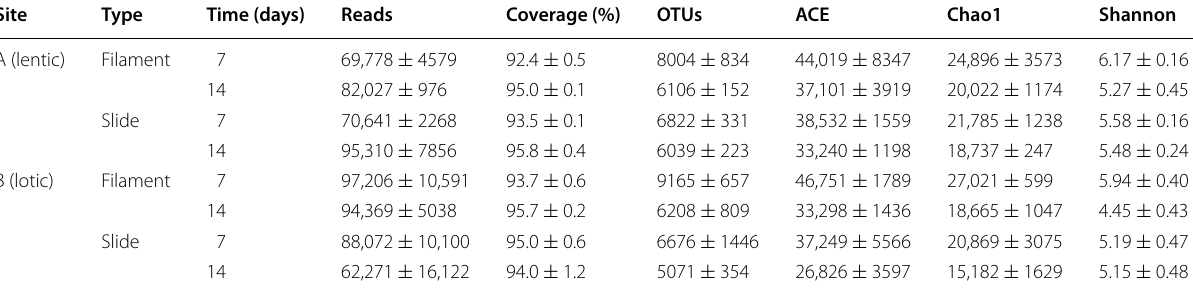
ACE, abundance-based coverage